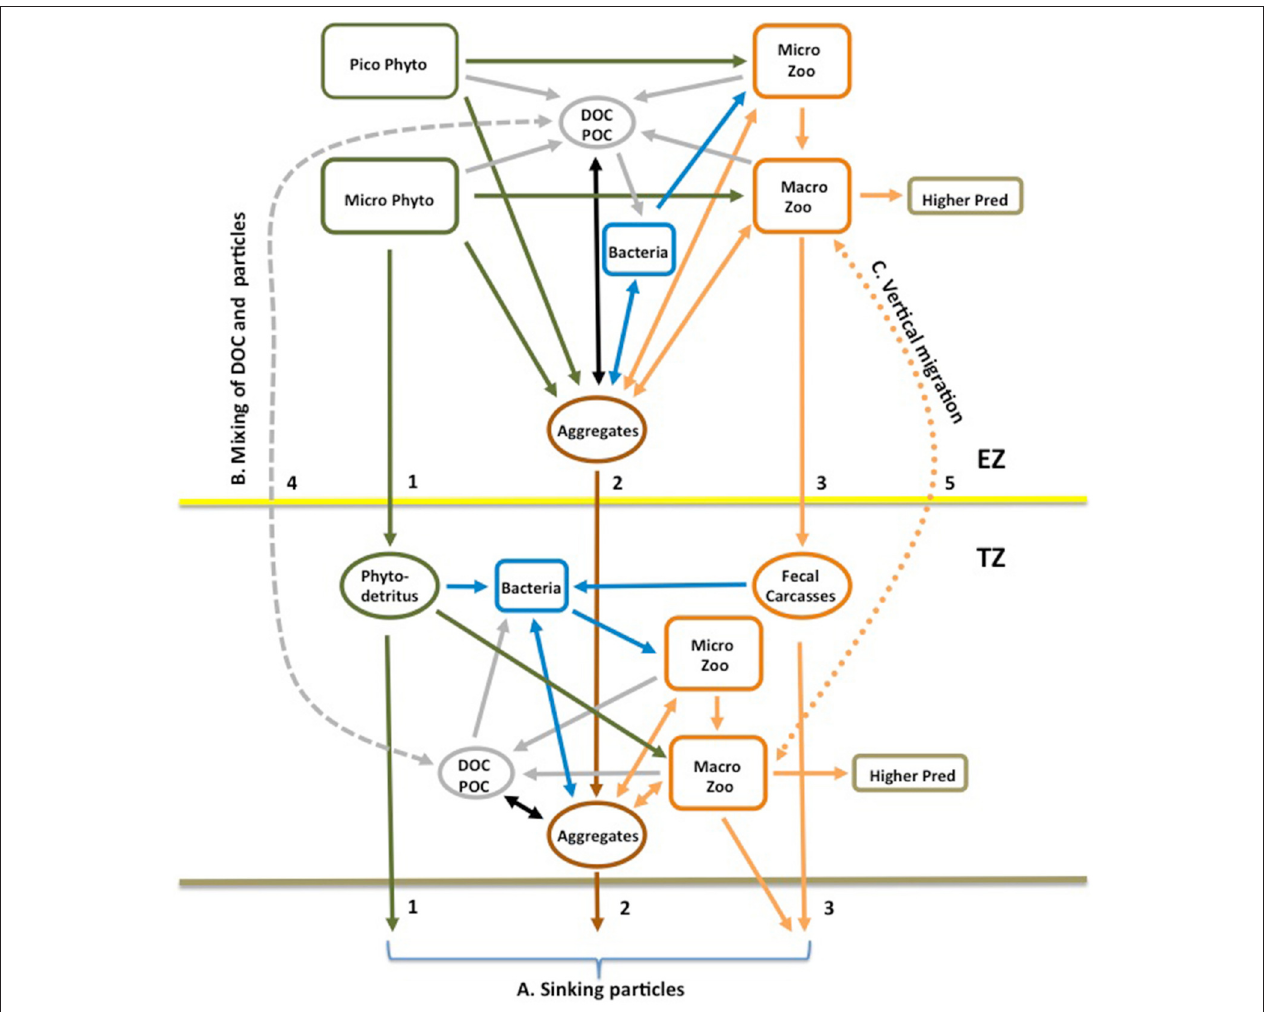
FIGURE 4 | The EXPORTS wiring diagram illustrating the C flows from the euphotic zone (EZ) into the twilight zone (TZ) in the biological pump. The flow of C through the biological pump is comprised of (A) sinking particles, (B) the advective mixing of DOC and suspended C stocks, and (C) active transport via migrating